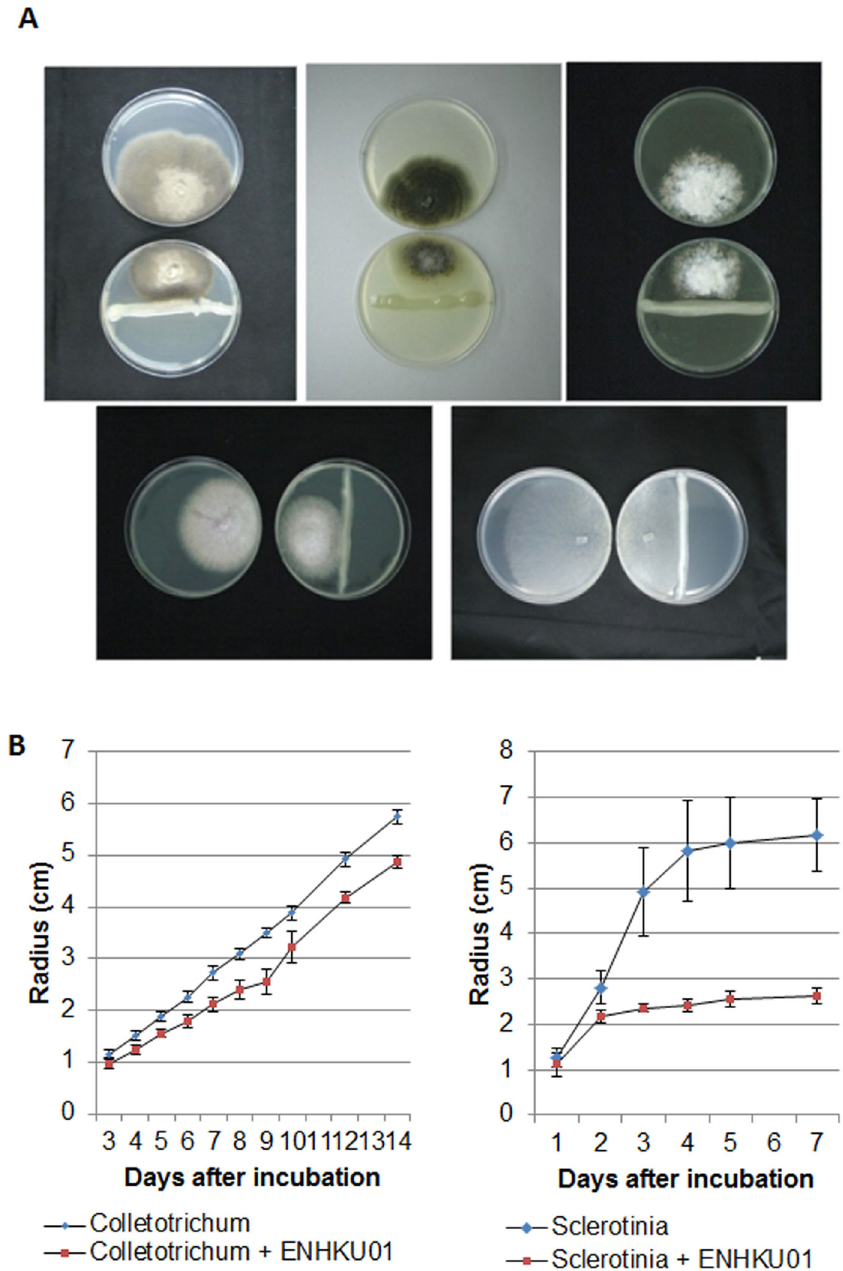
Figure 8. Antagonistic activity of E. cloacae subsp. cloacae ENHKU01 against fungi. (A) Visualization of fungal growth with and without ENHKU01: (from left to right, upper row) Alternaria sp., Colletotrichum capsici , Didymella bryoniae , (from left to right, lower row) Fusarium oxysporum and Sclerotinia sclerotiorum . Photos were taken 7 days after incubation; (B) Growth of Colletotrichum capsici (Col) and Sclerotinia scleotiorum (Scl) were closely monitored with and without ENHKU01. Challenging fungi were grown on PDA plates as described in Methods and Materials, the radius of growth of hyphae (in cm) was measured. Numbers show an average of 10 plates, and error bars represent the S.D. from the